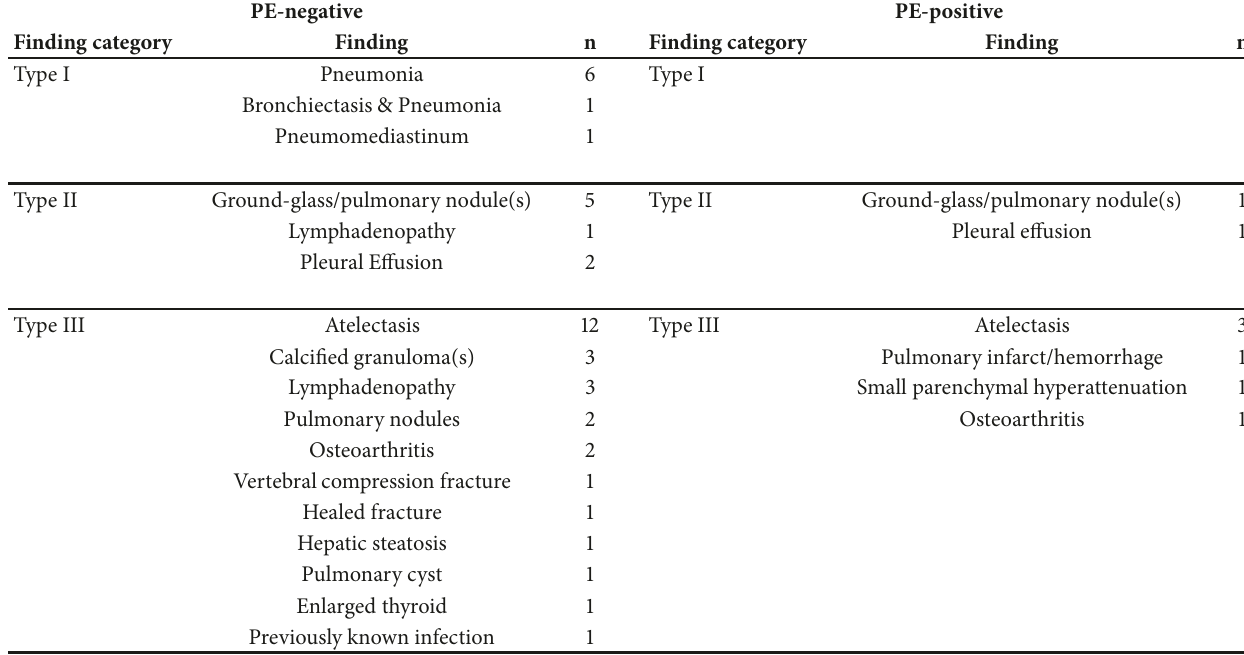
Table 2: Incidental findings made by CTPA, categorized by PE detection status (positive or negative) and finding type (types I, II, and III), representedas number (n) of said finding. When multiple pathologies were identified, incidental findings were categorized based on the most immediately harmful